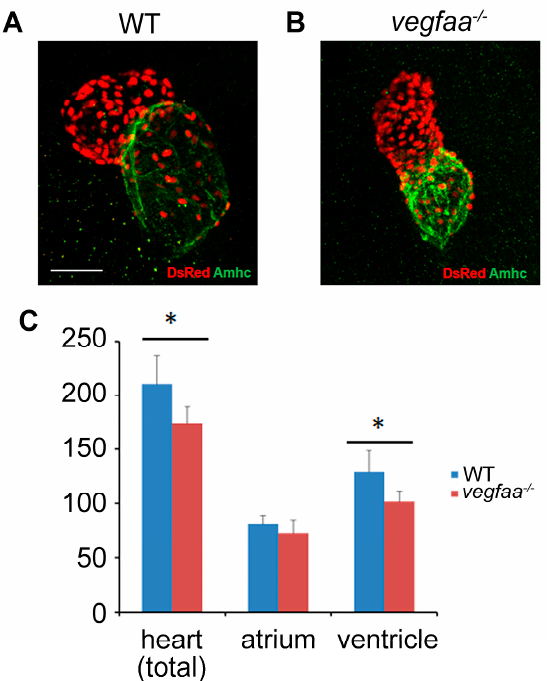
Figure 5. vegfaa promotes cardiomyocytes proliferation. ( A , B ) Immunofluorescence indicates the expression of transgene Tg ( myl7:nDsRed ) (red) in both cardiac chambers facilitating cardiomyocyte counting at 48 hpf. Atria are labeled with the anti-Amhc (atrial myosin heavy chain) antibody S46 (green); ( C ) Bar graphs indicate the number of atrial and ventricular cardiomyocyte nuclei, as well as the total number of cardiomyocytes; asterisks indicate statistically significant differences compared to wild-type ( p < 0.05) (WT n = 5; vegfaa − / − n = 5).